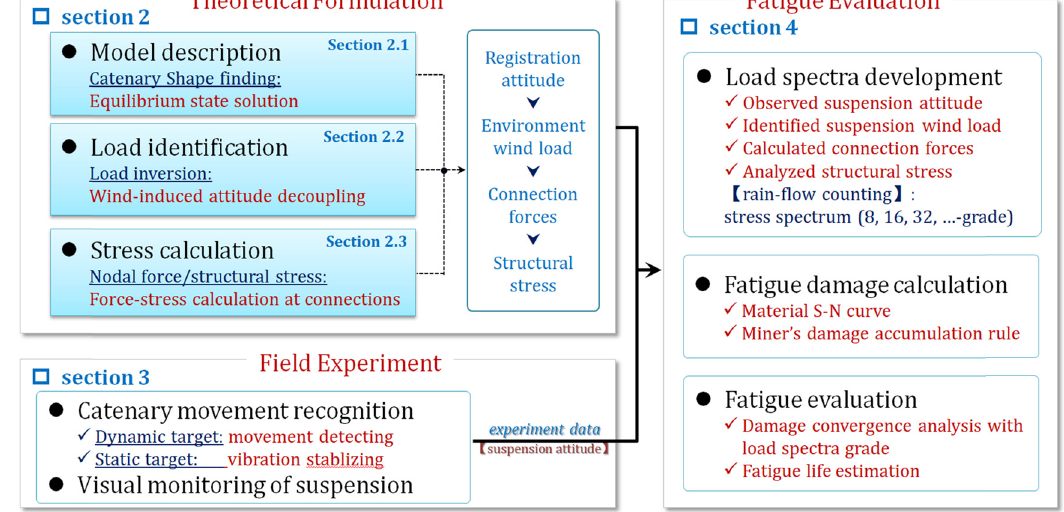
Figure 2: Technical route of the proposed